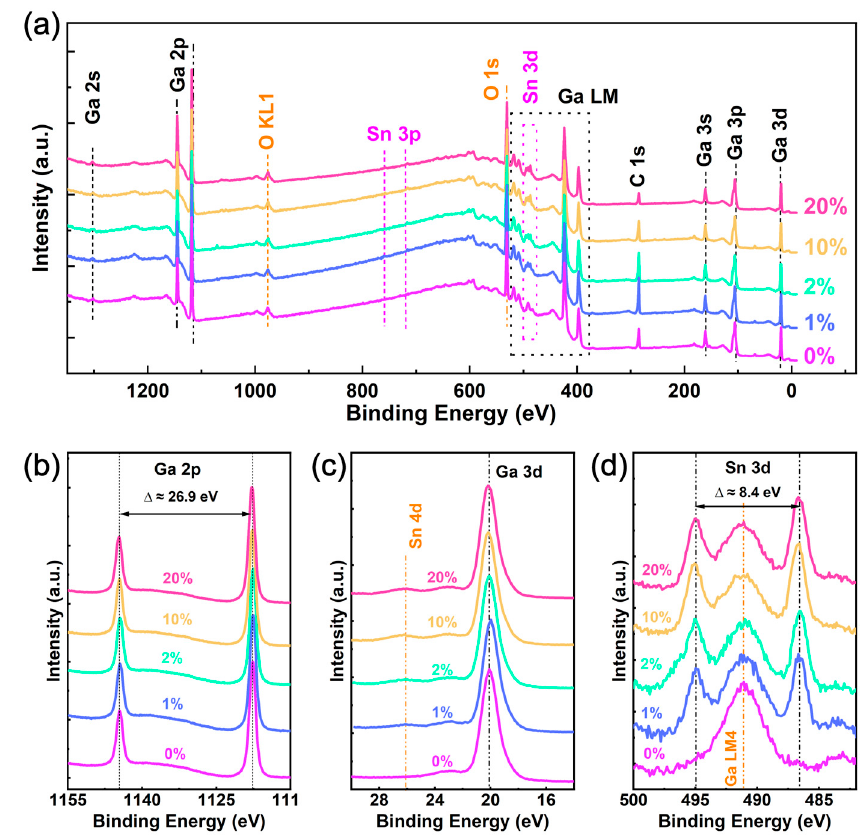
Figure 1. Graphs depicting the results of the XPS analysis of the annealed Ga 2 O 3 thin films with 0%, 1%, 2%, 10%, and 20% Sn composition: ( a ) survey peaks, ( b ) Ga 2p spectra, ( c ) Ga 3d spectra, and ( d ) Sn 3d spectra.